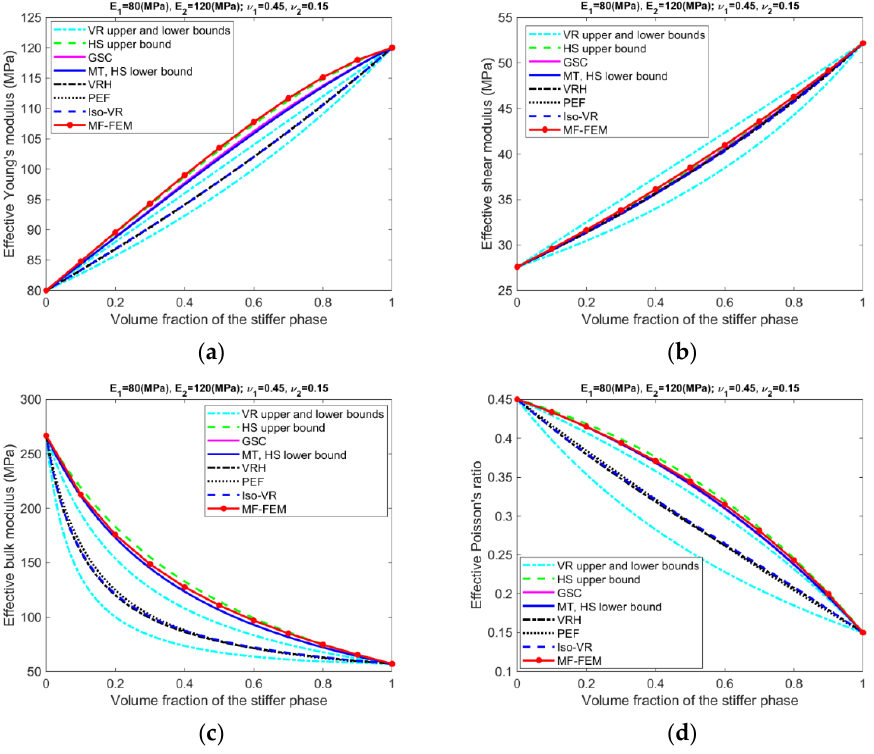
Figure A2. Composite #2—small contrast in phase Young’s modulus and large contrast in phase Poisson’s ratio. ( a ) Young’s modulus; ( b ) shear modulus; ( c ) bulk modulus; ( d ) Poisson’s ratio.